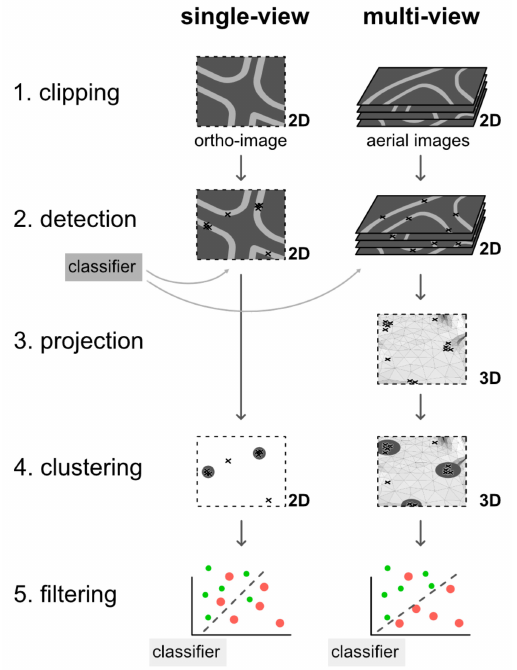
Figure 1. Single-view and multiview detection approaches. The multiview approach uses all available image information for detection and performs clustering in three-dimensional (3D)